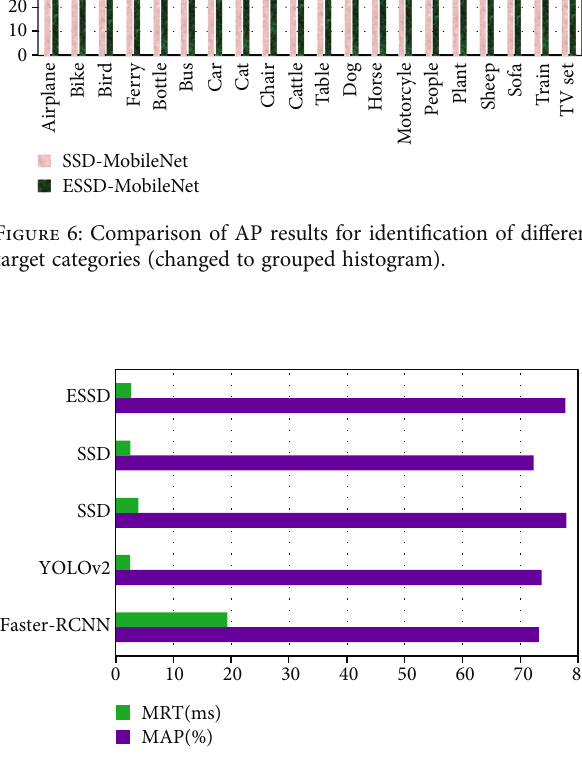
Figure 7: Comparison of image retrieval results of di ff erent target recognition algorithms (changed to bar